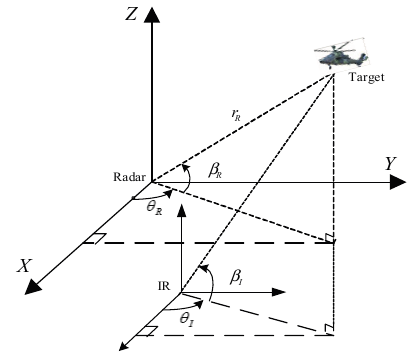
Figure 1. Geometry measuring relationship between target and radar/IR